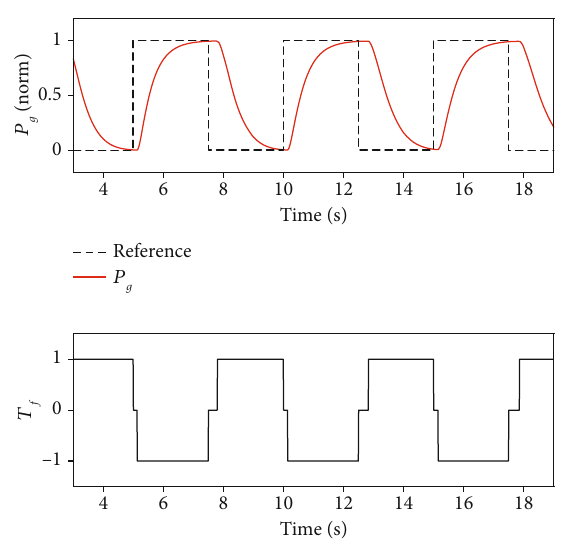
Figure 9: Observation of touch state in a fl ow regulation.